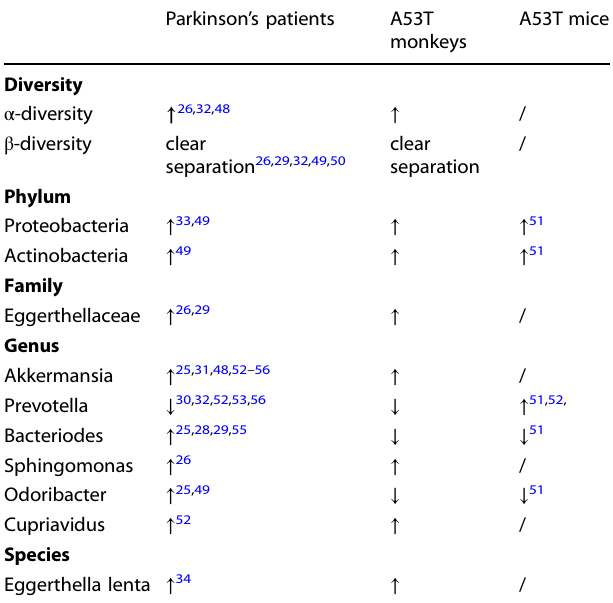
(Supplementary Table 3). All of the animals were individually caged. The animal room was set on a 12 h light:12 h darkness cycle. The temperature and the humidity of the animal room were kept at 18 – 26 °C and 40 – 70%, respectively. The animals were fed twice per day with commercial monkey